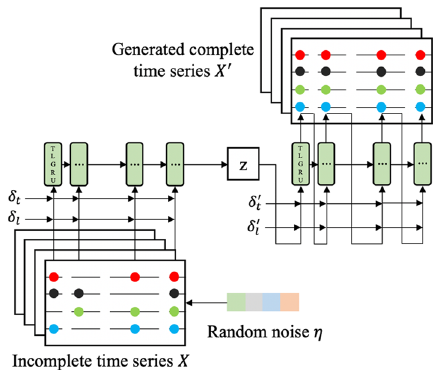
Fig. 3 The architecture of the generator. The generator is a denoising auto-encoder which is mainly composed by the TLGRU